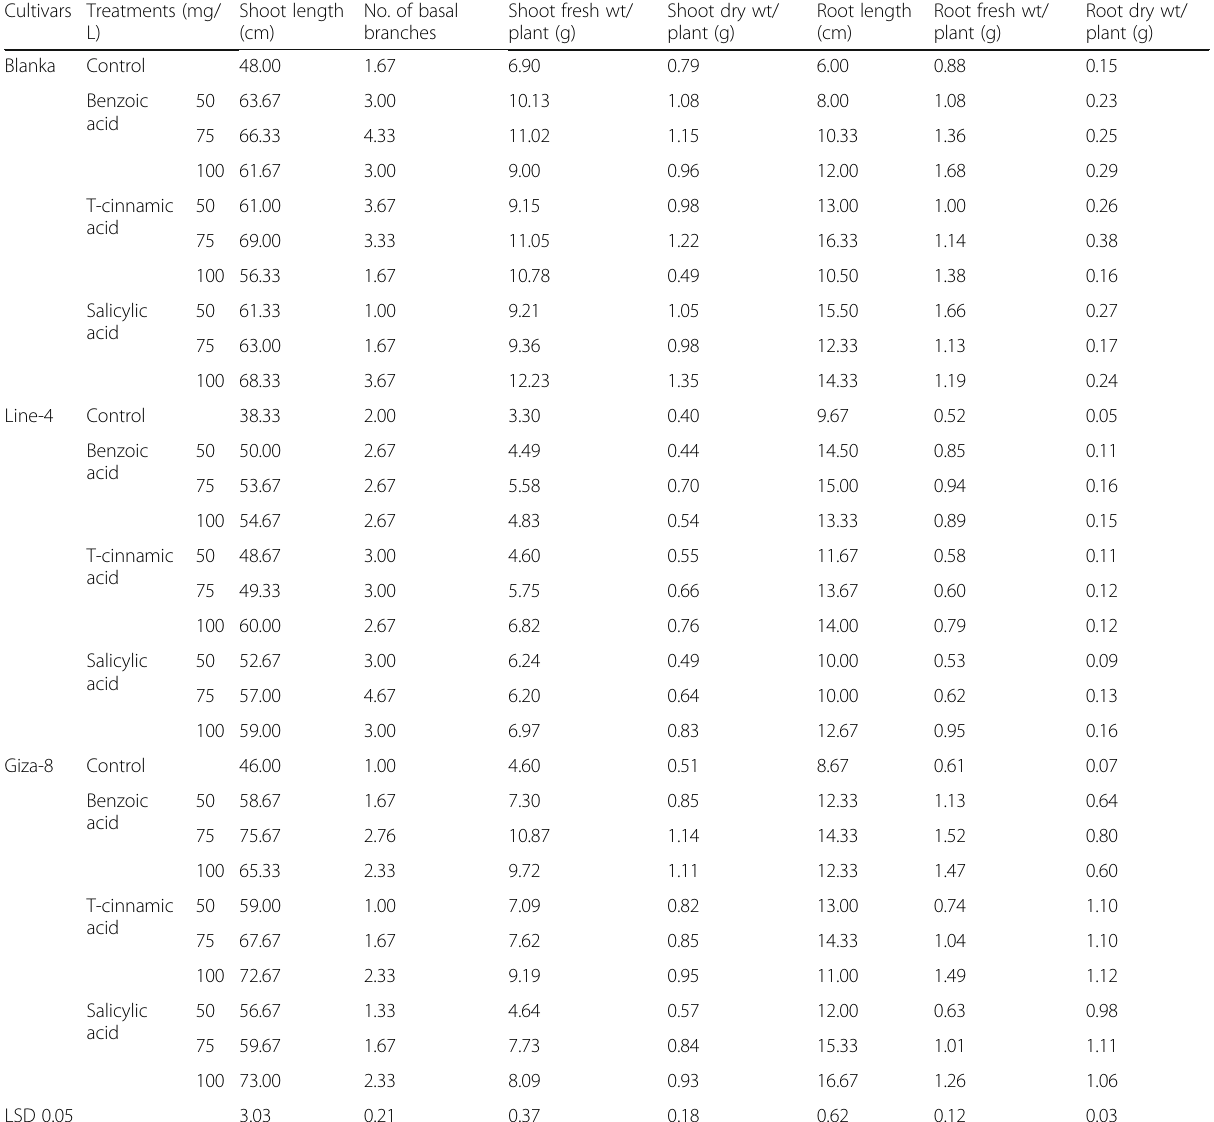
Table 20 Effect of interaction between benzoic, t-cinnamic, and salicylic acids on growth parameters of flax varieties grown under sandy soil conditions (data are means of two successive seasons) Cultivars Treatments (mg/ Shoot length No. of basal Shoot fresh wt/ L) (cm) branches plant